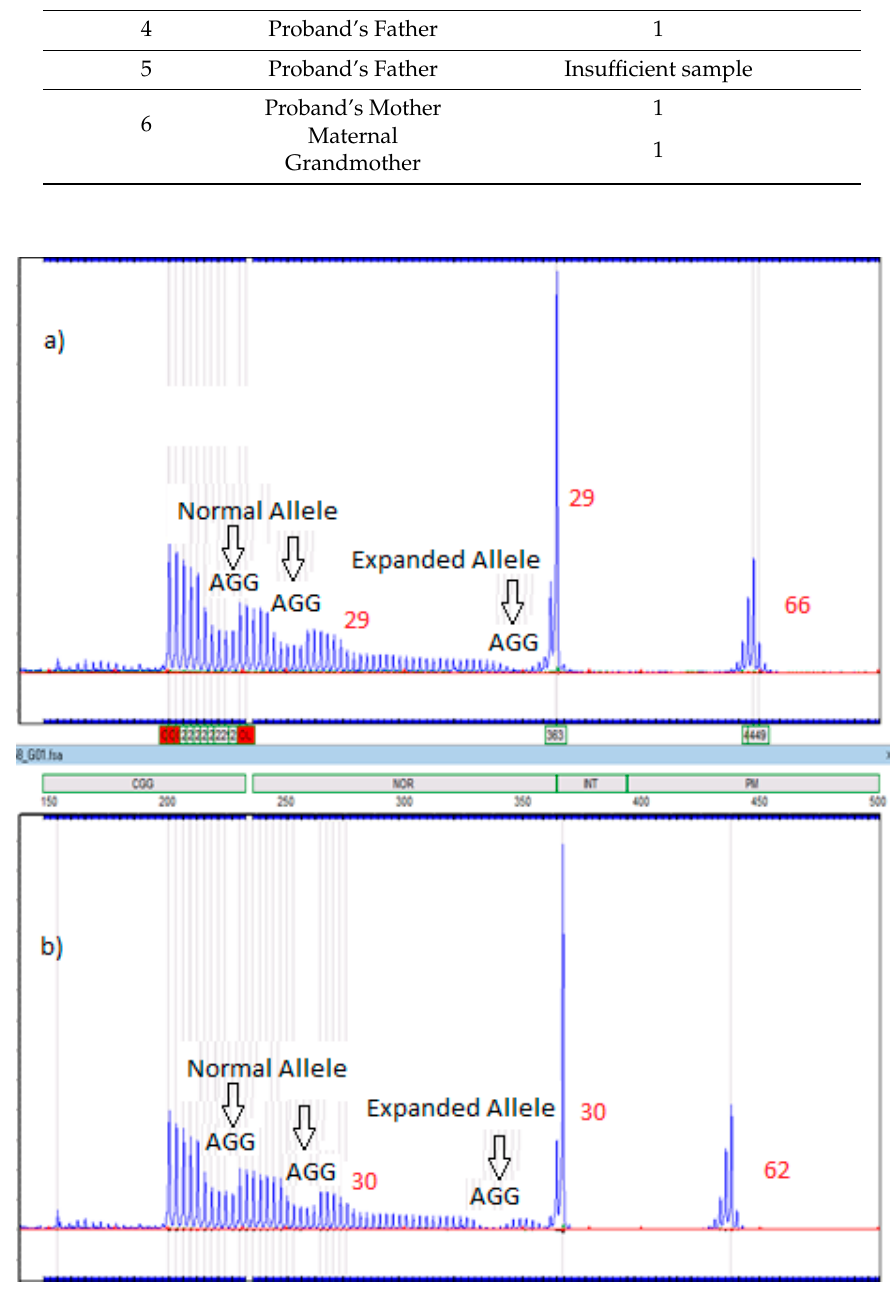
Figure 3. Electropherograms of the proband’s mother ( a ) and the maternal grandmother ( b ) (Case 6) which are 29, 66 CGG and 30, 62 CGG, respectively. They both have two AGG interrupts in the normal allele and one AGG interrupt in the expanded